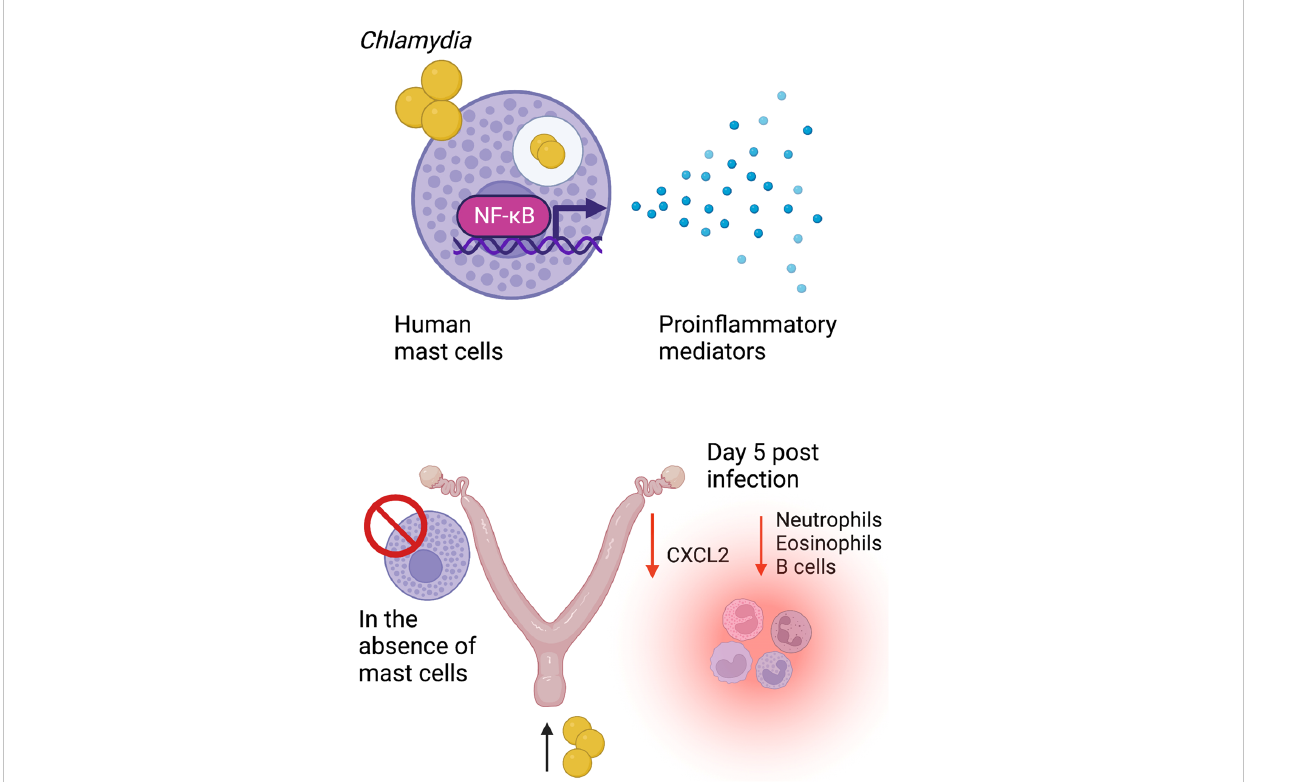
FIGURE 8 Mast cells selectively produce in fl ammatory mediators and impact the early responses to Chlamydia reproductive tract infection. Human mast cells sparsely take up Chlamydia , do not undergo degranulation, and are resistant to its intracellular life cycle. Mast cell – Chlamydia interaction occurs downstream of the NF-kB-mediated pathway with an upregulation of the expression of several in fl ammatory genes along with the production of proin fl ammatory mediators at the protein level. In the absence of mast cells in vivo , mice display an altered chemokine environment with reduced recruitment of effector cells, including neutrophils, eosinophils, and B cells into the reproductive